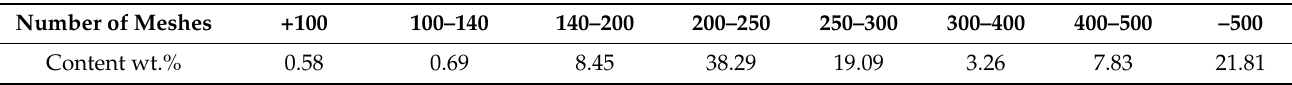
Table 1. Niobium ore production statistics of each grain